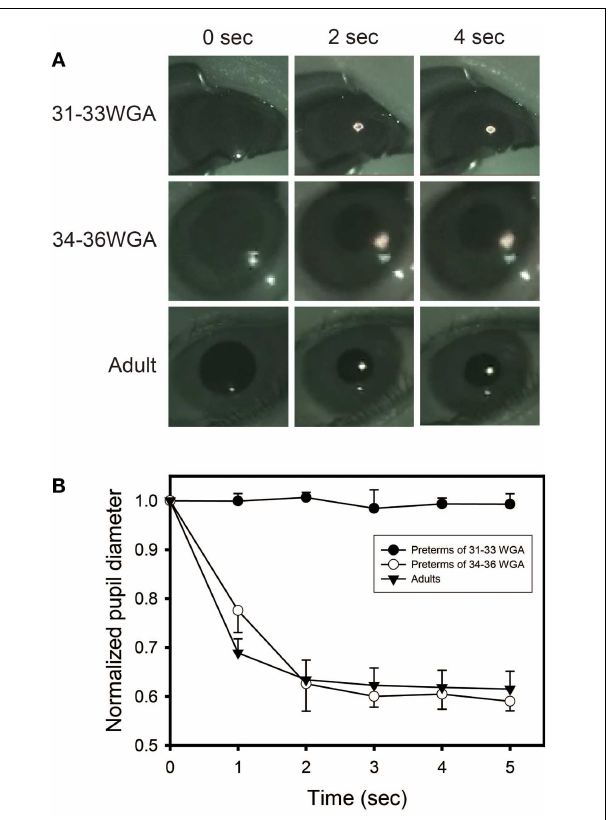
FIGURE 4 | Preterm infants exhibit a slower pupillary light reflex (PLR) to white light . (A) Preterm infants and adults all showed consensual pupillary constriction in response to 5s of white light (quartz halogen source, 15.3 µ W/cm 2 ), but the constriction was slower in preterm infants than in adults. Preterm infants of 31–33weeks’ gestational age exhibit a slower PLR to white light, particularly observed during the first 2s after light exposure. (B) Time courses of PLRs in preterm infants and adults to white light (quartz halogen source, 15.3 µ W/cm 2 , 5s)The diameter of the normalized pupil is expressed as a ratio of its size to the size of the dark-adapted pupil diameter (recorded just before light exposure, time 0 on the graph).The normalized pupil diameter “1.0” indicates the maximum diameter of the dark-adapted pupil.Values are mean ± SD for the five subjects per each group.